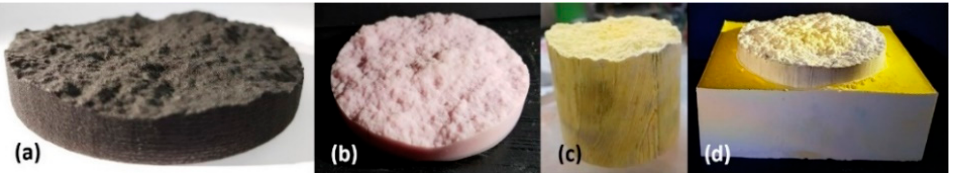
Figure 2. Preparation procedure of joint specimens; ( a ) 3DP mold, ( b ) silicone mold, ( c ) plaster rough joint, ( d ) encapsulated joint.